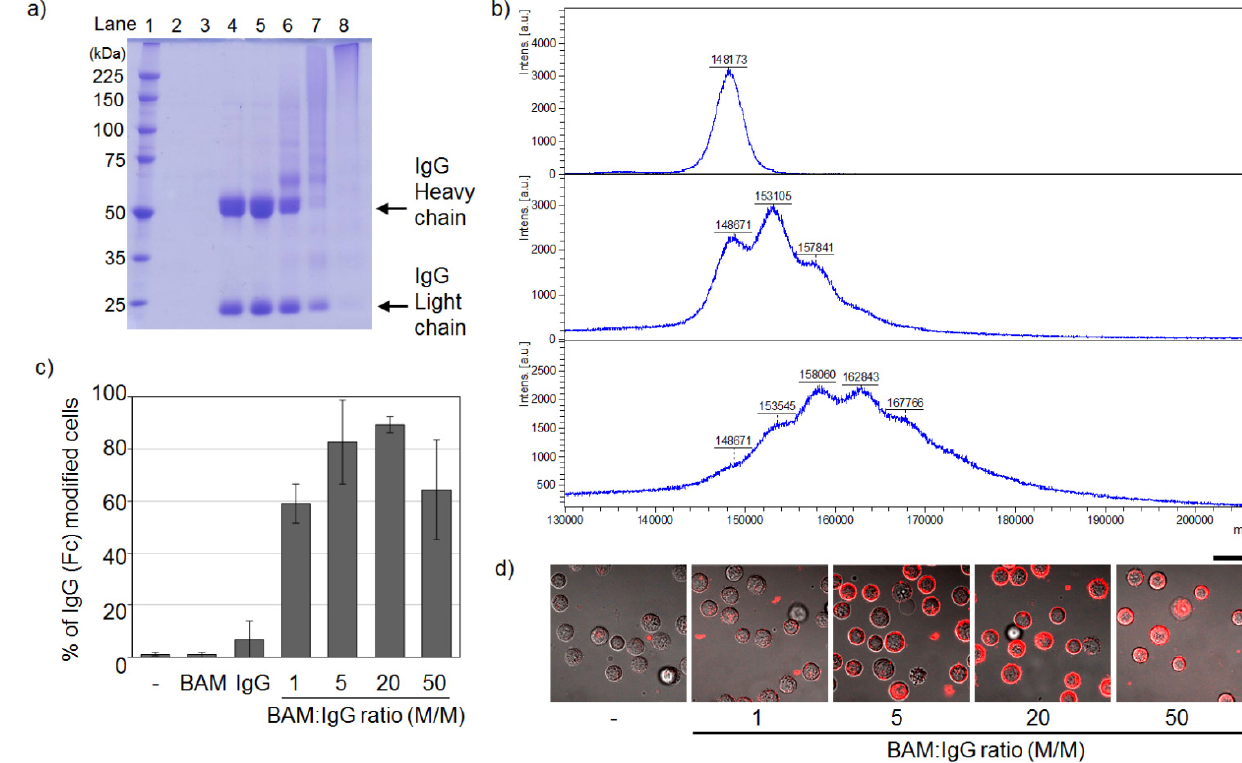
Figure 2. Optimization of the condition of IgG-BAM conjugation by changing the final molar ratio of BAM to IgG. ( a ) Qualitative analysis of the attachment of BAM to IgG by a reducing 7.5% polyacrylamide SDS-PAGE gel stained with Coomassie brilliant blue. Lane 1, protein molecular weight markers in kDa; lane 2, PBS as a control; lane 3, BAM as a control; lane 4, IgG as a control; lanes 5  8; IgG treated with BAM at various ratios: 1:1, 1:5, 1:20 and 1:50; ( b ) MALDI-TOF MS spectra of intact IgG (top), IgG treated with BAM at the IgG:BAM ratio of 1:5 (middle) and 1:20 (bottom); ( c ) Qualitative analysis of the incorporation of IgG-BAM conjugates into the membrane of HeLa cells by flow cytometry. (n = 3); ( d ) CLSM observation. Bar = 40